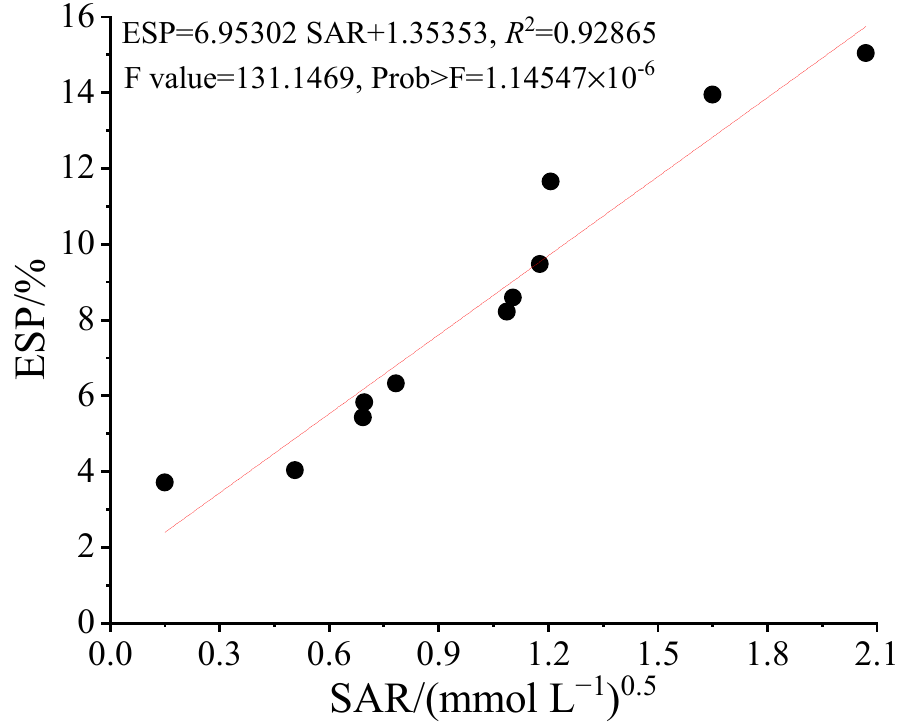
Figure 6. Relationship between soil ESP and SAR.